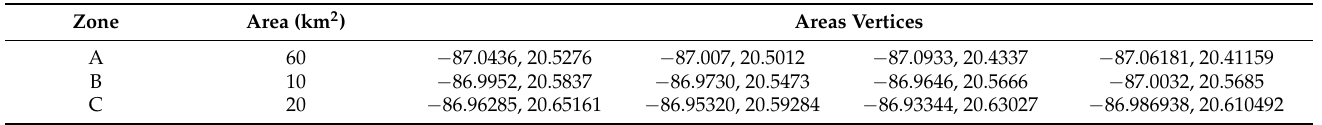
Table 7. Area in the Cozumel